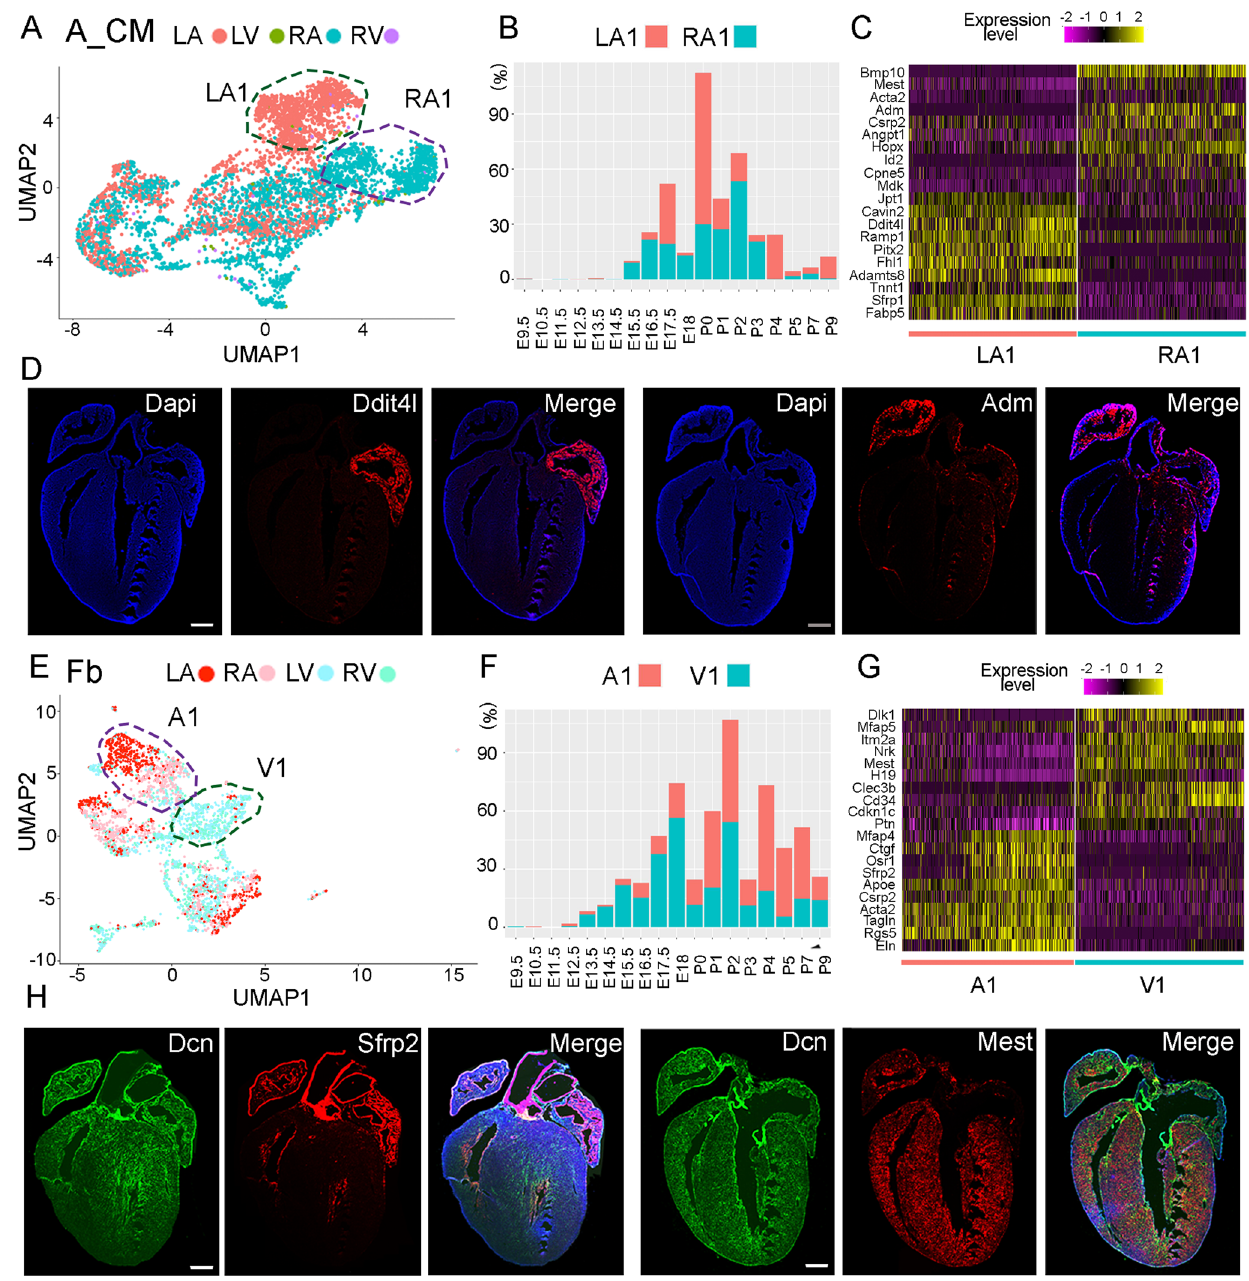
Fig. 3 | Chamber-speci fi c molecular features of atrial CMs and fi broblasts. A UMAP of A_CMs labeling the LA and RA-speci fi c populations (LA1, RA1). B Stage analyses of LA1 and RA1 cells. C Expression heatmap of the top 20 genes differ- entiallyexpressedinLA1 and RA1 cells. D mRNAstaining con fi rmed the LA-speci fi c expression of Ddit4l and RA-speci fi c expression of Adm . E UMAP of fi broblasts